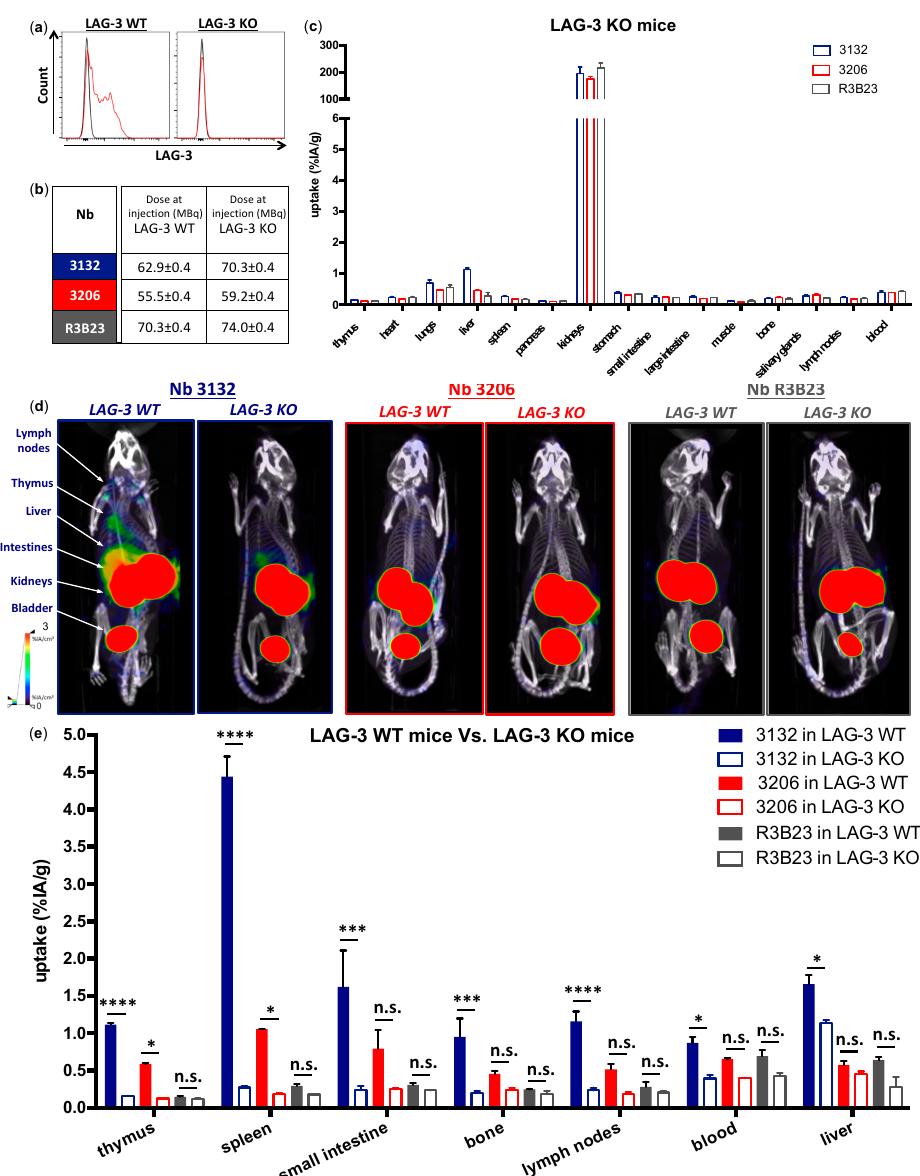
Figure 5 . Characterization and in vivo SPECT/CT imaging with anti-moLAG-3 Nbs in LAG-3 knock-out (KO) mice. ( a ) Flow cytometry analysis of moLAG-3 expression on stimulated lymphocytes from LAG-3 WT and LAG-3 KO mice. The flow cytometry graphs are representative for three independent mice ( n = 1). ( b ) Dose of in vivo injected 99m Tc-Nb conjugates in LAG-3 WT or LAG-3 KO mice. ( c ) Ex vivo γ -counting of isolated organs from LAG-3 KO mice 80 min after injection of 99m Tc-labeled Nbs targeting moLAG-3 or control Nb R3B23. The graph summarizes the data obtained in three mice as mean ± SD of %IA/g ( n = 1). ( d ) Representative SPECT/CT scans of LAG-3 WT mice (left) and LAG-3 KO mice (right) 60 min after injection of 99m Tc-labeled Nb 3132, 3206, or control Nb R3B23. ( e ) Ex vivo γ -counting of isolated organs from LAG-3 WT mice and LAG-3 KO mice 1 h after injection of 99m Tc-labeled Nbs targeting moLAG-3 or control Nb R3B23. The graph summarizes the data obtained in three mice as mean ± SD of %IA/g ( n = 1).